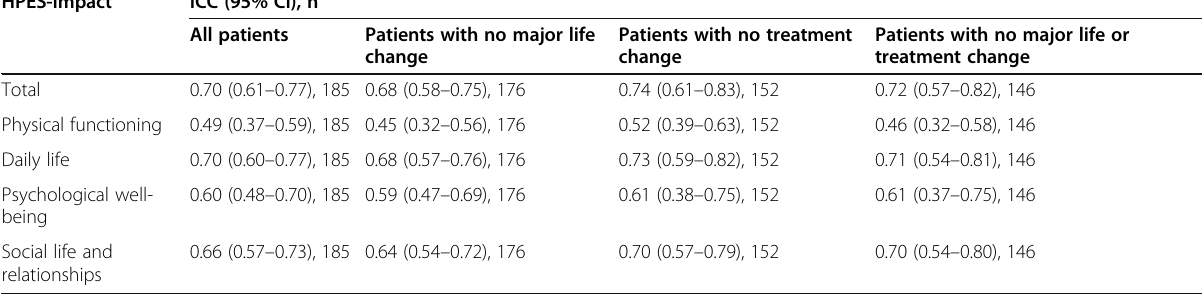
Table 7 Observational study HPES-Impact test-retest reliability, baseline to week 2